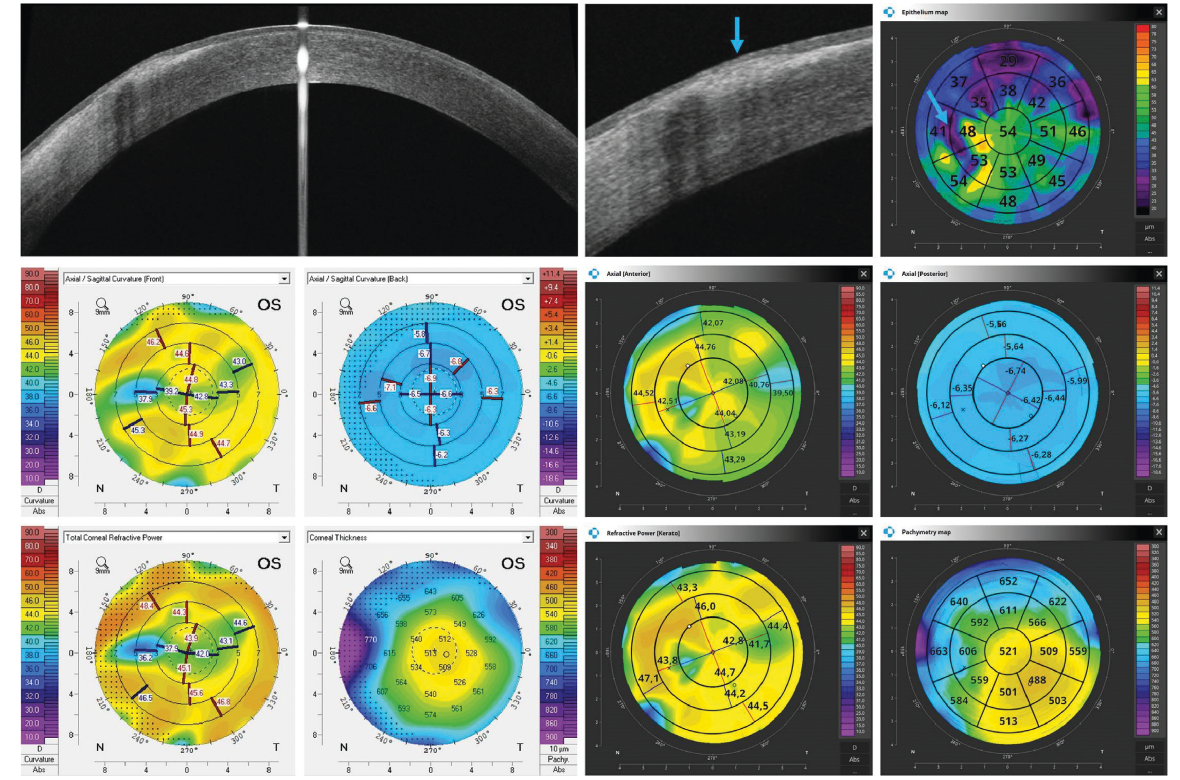
Figure 2: Postpterygium surgery OCT tomogram shows an irregular reduction in the epithelial thickness across the entire upper and partially nasal portions of the central cornea on the ETM (blue arrows). Topography maps reveal irregular astigmatism of the anterior surface of the cornea while the posterior surface is regular. The measurements performed with Pentacam have a white background, and the ones performed with REVO NX have a black background. The K1, K2, and astigmatism values for the anterior surface of the cornea obtained using Pentacam are 41.2 D, 44.8D, and 3.6D, respectively, while the values obtained using REVO NX are 41.4 D, 44.5D, and 3.1D, respectively. The values of analogous parameters for the posterior corneal surface from Pentacam are − 6.5D, − 6.6D, and 0.1D and the values from REVO NX are − 6.2D − 6.5 D